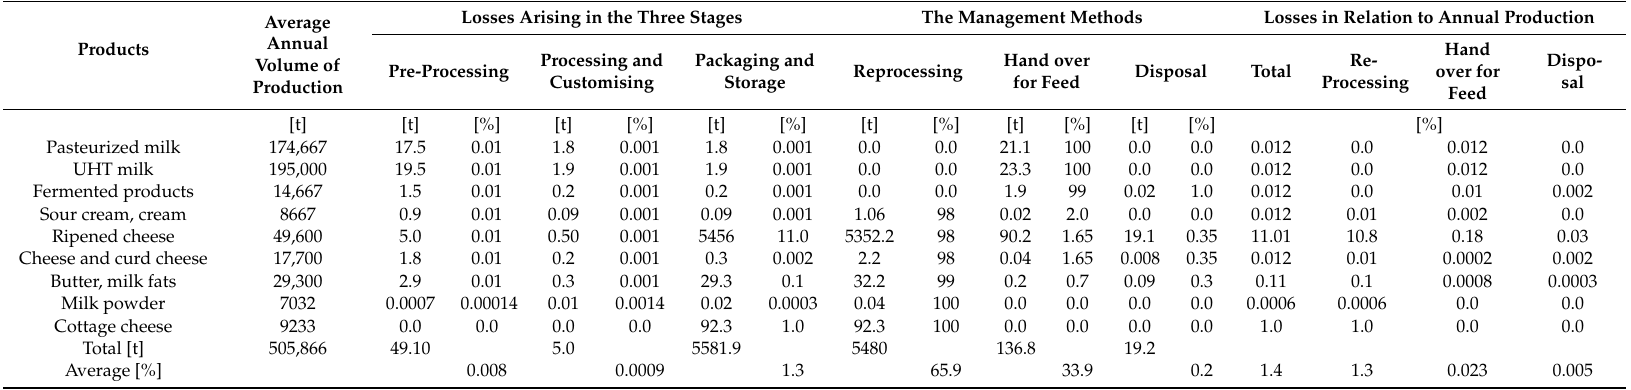
Table 4. The average annual volume of dairy production, the management methods, and the losses that occur in the three stages of the production process in the five plants studied [t] and